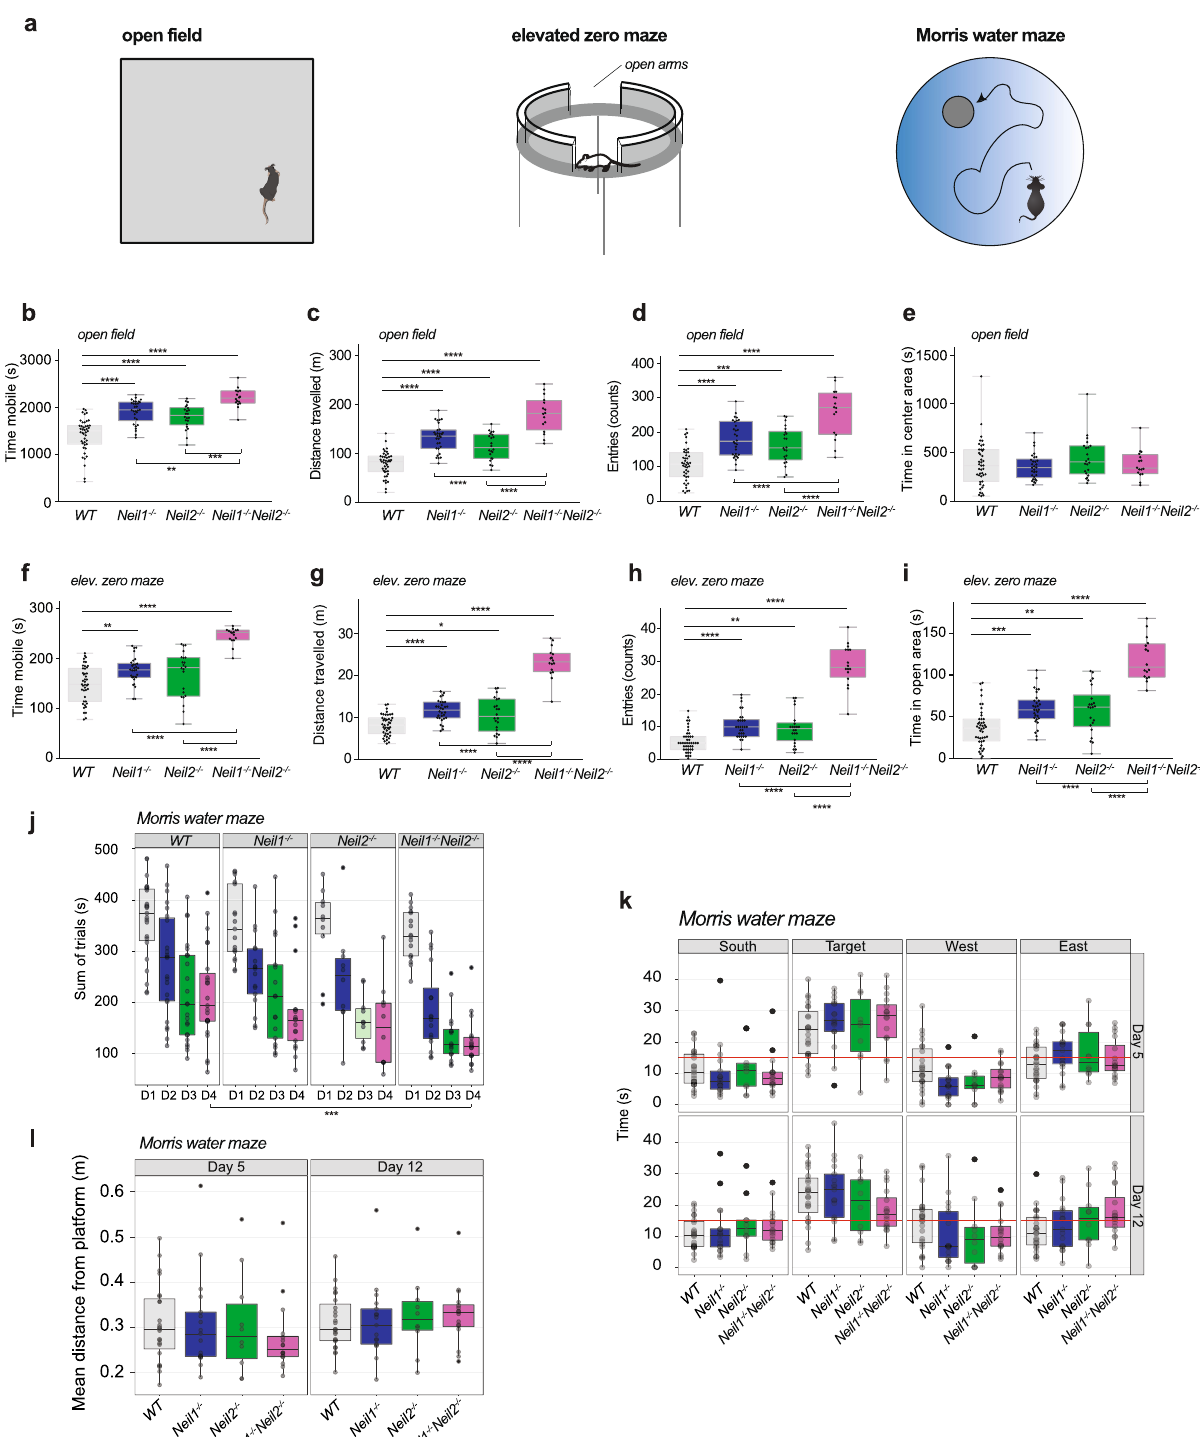
Neil1 − / − Neil2 − / − hippocampi, as compared to WT ( P = 0.0856) (Supplementary Fig. 2). In sum, our data suggest that the beha- vioral phenotype observed in Neil1 − / − Neil2 − / − mice were not caused by impaired canonical